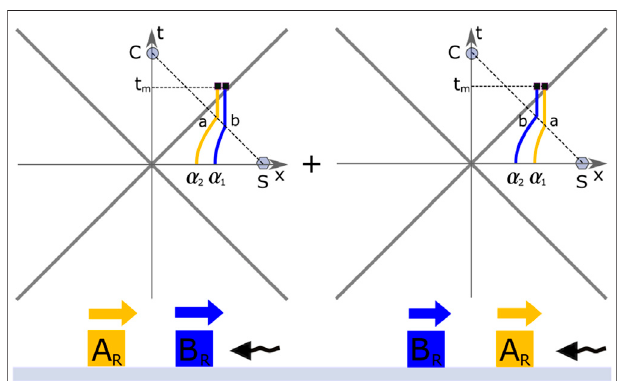
FIGURE 2 | Entangled Rindler observers. Worldline of a photon emitted by the source S intersects worldlines of the two Rindler observers, A R and B R , that have entangled proper accelerations. On the left panel, A R has greater proper acceleration ( α 2 ) than B R ( α 1 ) , and on the right panel the accelerations are “ switched ” . By choosing a suitable pair of values for the properaccelerations,thesemeetings(events a and b )occuratthesameproper time τ * . Rindler observers act on the polarization of the photon according to their “ color ” , amber ( A ) or blue ( B ), that distinguishes them. Observer A R performs a unitary transformation U A at τ * and observer B R performs a unitary transformation U B at τ * . When Rindler observers meet the photon, they come to rest and remain that way until some particular moment t m at which a projective measurement is performed in order to disentangle the state of the photon from that of the Rindler observers. The photon is observed at C .